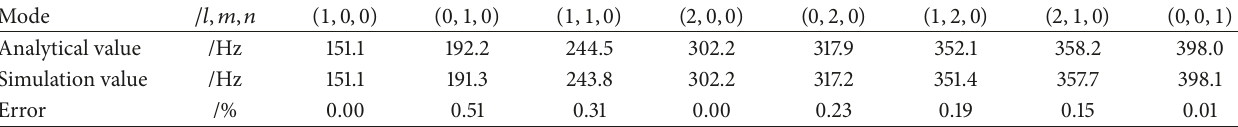
Table 2: Comparison of acoustic modes achieved by analytical method and simulation